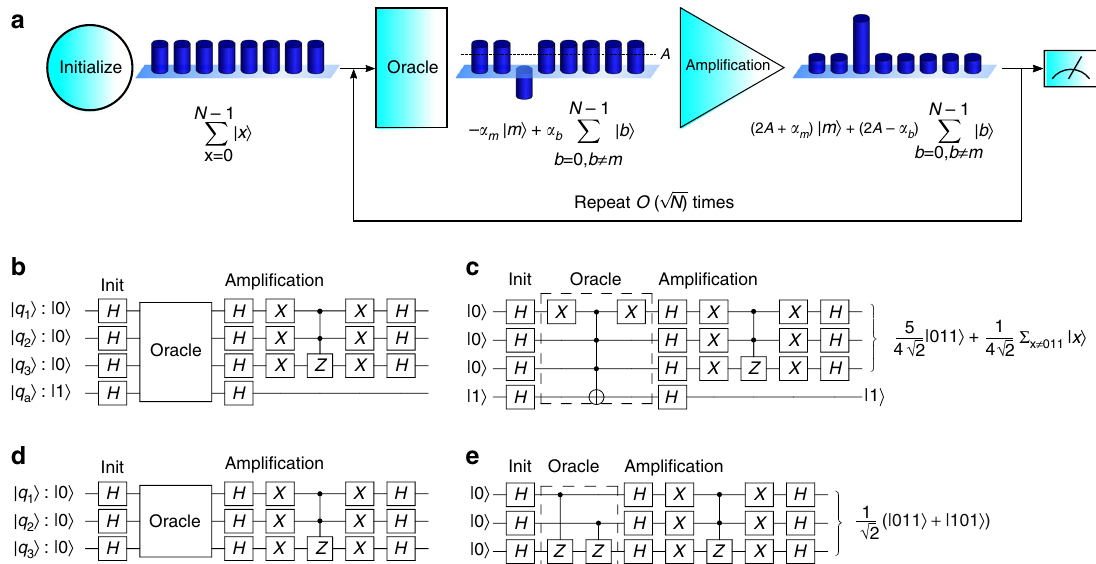
Fig. 1 The Grover search algorithm. a Evolution of relative amplitudes for each state during a Grover search algorithm. The initialization stage creates an equal superposition of all possible input states, so the amplitude α x = 1 for all basis states | x 〉 . The oracle stage marks the desired state, so the amplitude α m of the marked state | m 〉 becomes negative while the amplitudes α b of the unmarked states | b 〉 , b ≠ m remain unchanged. The ampli fi cation stage performs a P P N (cid:3) 1 N (cid:3) 1 x j i , which has amplitude A ¼ 1 α x ¼ 1 (cid:3) α m þ N (cid:3) 1 ð Þ , to amplify the marked state. An appropriate re fl ection about the mean vector x ¼ 0 x ¼ 0 N N number of repetitions of the oracle and ampli fi cation stages will maximize the amplitude of the correct answer. All qubit states are normalized by the factor 1 ffiffiffi p . The algorithm can also be generalized to mark and amplify the amplitude of t desired states. b General circuit diagram for a Grover search algorithm N using a Boolean oracle, depicted using standard quantum circuit diagram notation 16 . The last qubit q a is the ancilla qubit. c Example of single-solution Boolean oracle marking the | 011 〉 state. d General circuit diagram for a Grover search algorithm using a phase oracle. e Example of two-solution phase oracle marking the | 011 〉 and | 101 〉